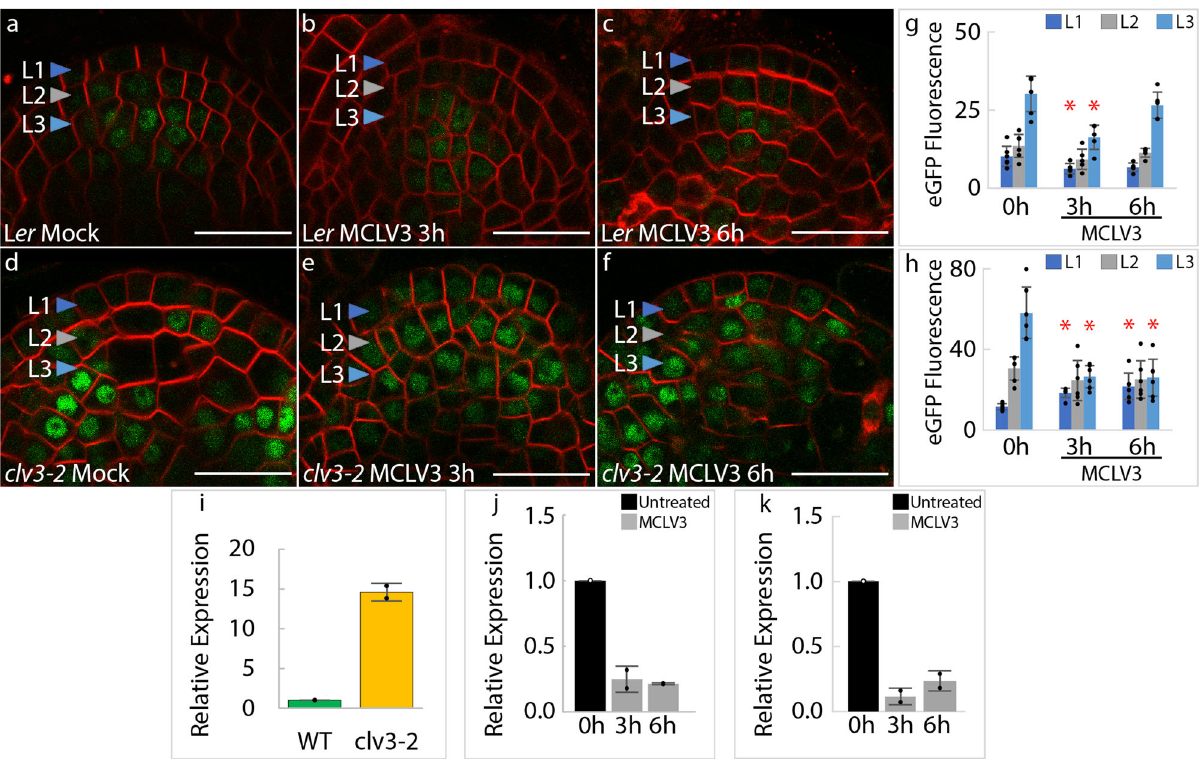
Fig. 1 Short-term MCLV3 peptide application rapidly decreases WUS transcription but maintains the WUS protein. pWUS:: eGFP-WUS reporter response in 7-day old a mock-treated ( n = 6), b 1 μ M MCLV3 treatment for 3 h ( n = 5), or c 1 μ M MCLV3 treatment for 6 h ( n = 5) in wild-type SAMs. pWUS:: eGFP-WUS reporter response in 7-day old d mock-treated ( n = 6), e 1 μ M MCLV3 treatment for 3 h ( n = 6), or f 1 μ M MCLV3 treatment for 6 h ( n = 6) in clv3-2 SAMs. g , h Quanti fi cation of pWUS:: eGFP-WUS fl uorescence levels (mean± s.d.) in g wild type or h clv3-2 SAMs shown in a – f . The “ n ” represents the number of independently treated plants. The * represents a p value ≤ 0.05 when compared to WUS levels at 0 h in the same cell layer (Student ’ s two-tailed t- test). eGFP (green) is overlaid on FM4-64 (red) plasma membrane stain. Scale bars = 20 μ M. i Quantitative RT-PCR analysis showing the relative combined WUS and eGFP-WUS expression (mean ± s.d.) in 7-day-old wild type ( n = 2) and clv3-2 mutants ( n = 2). The “ n ” represents the number of biological replicates. j , k Quantitative RT-PCR analysis showing relative combined WUS and eGFP-WUS expression (mean± s.d.) in response to 1 μ M MCLV3 treatment for 3 and 6 h in wild type ( j ) and clv3-2 mutants ( k ). Two biological replicates were used for each time point. UBQ10 was used as a reference gene to normalize the data and relative changes in WUS expression were determined relative to the levels at 0 h. Error bars represent the standard deviation